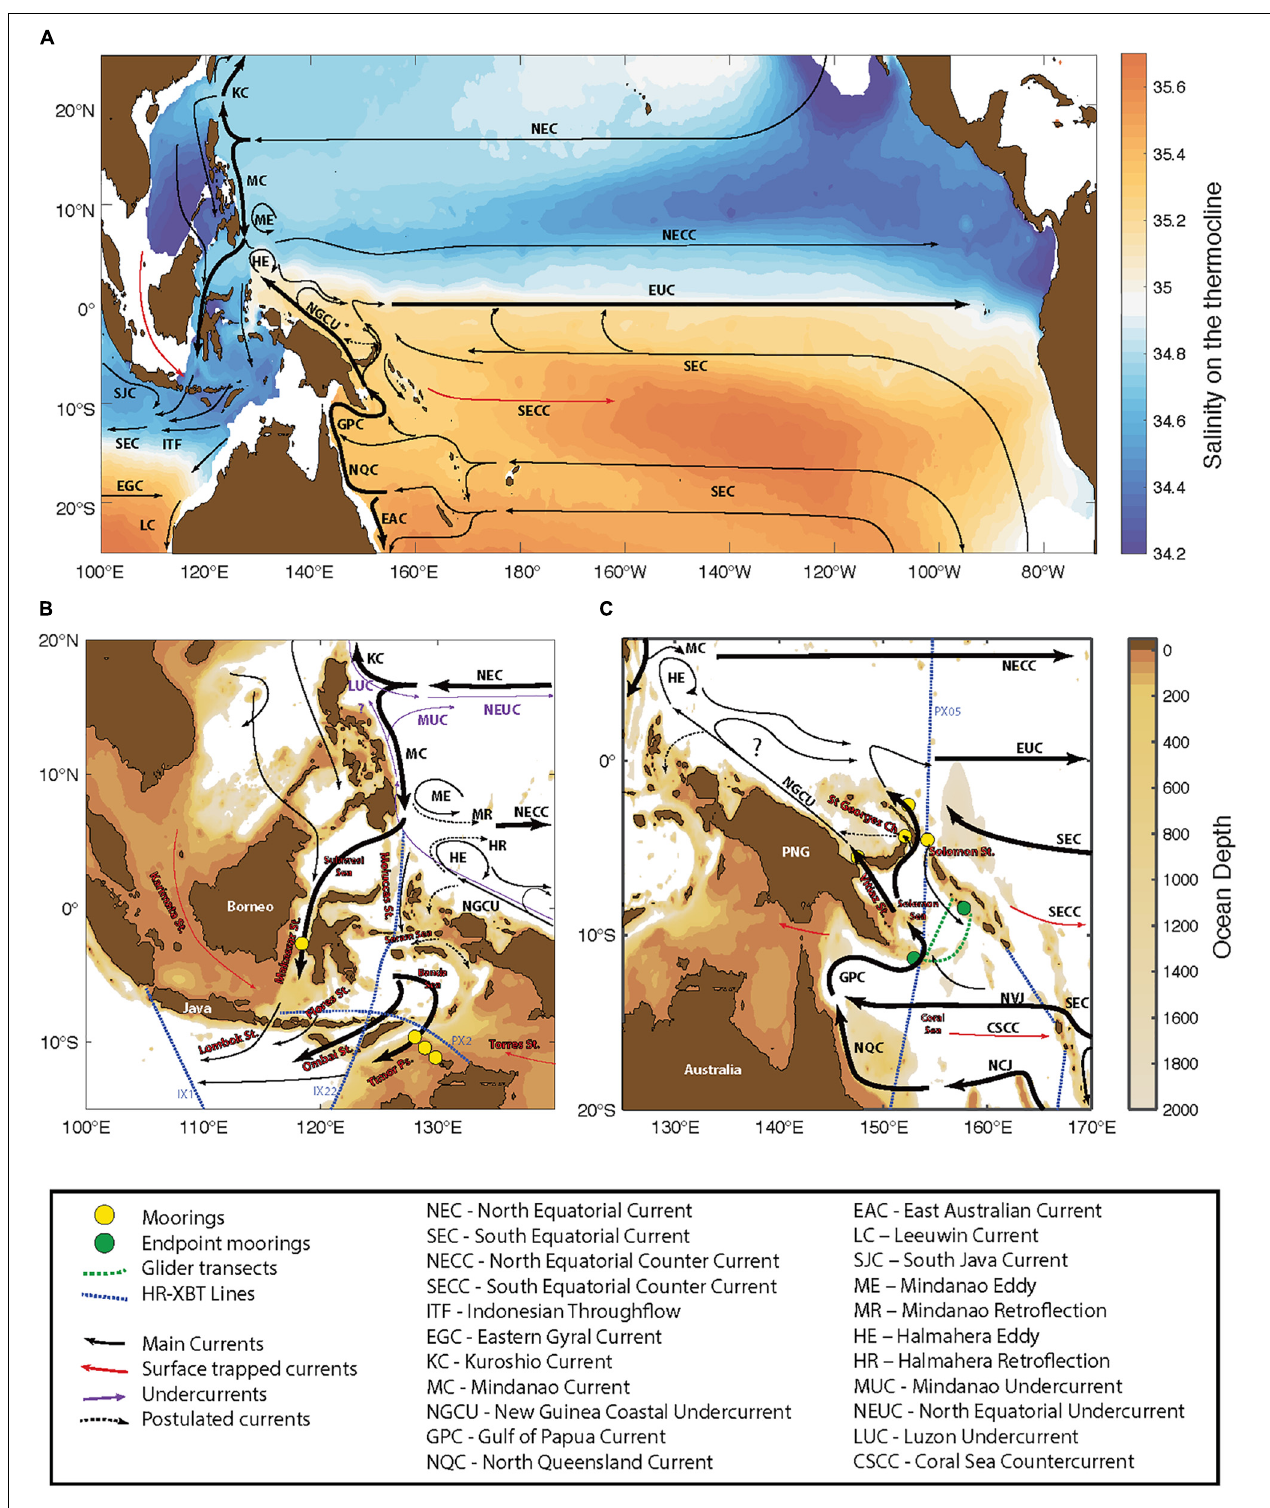
FIGURE 5 | Schematic showing the main circulation features for (A) the tropical Pacific, (B) the Indonesian Seas and (C) the tropical western Pacific. In (A) color shading shows mean salinity at thermocline level (20 ◦ C isotherm depth is used as a proxy) based on the BRAN2016 reanalysis (Oke et al., 2012); scale at right. Arrows highlight the flow pathways: Black at thermocline depth (thicker arrows are stronger), red for very shallow flows, dashed for postulated flows. Current names are listed in the legend at bottom. In (B,C) the brown shading shows the bathymetry (scale for both at right). Again arrows highlight the flow pathways, with purple arrows for undercurrents. Other observational arrays, including moorings, glider and XBT lines are added (legend).